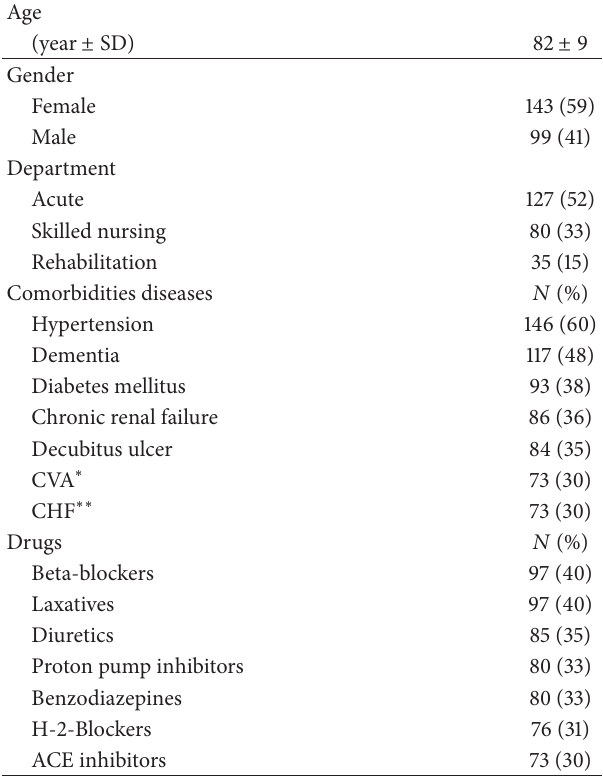
Table 1: Demographic and clinical data (242 elderly blood transfu- sion